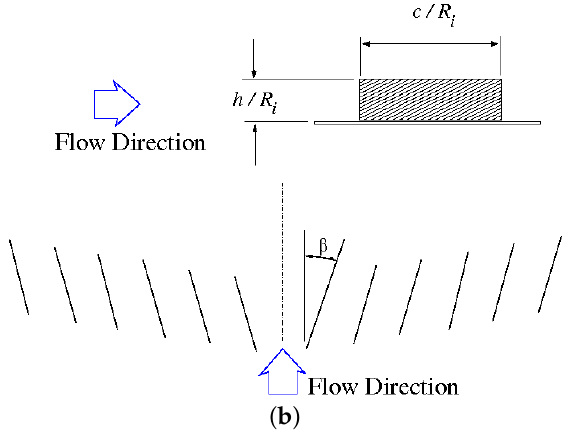
Figure 2. The RAE M2129 vortex generator locations and geometry parameters. These pictures were adapted from Ref. [12]. ( a ) VG locations; ( b ) Geometric parameters.